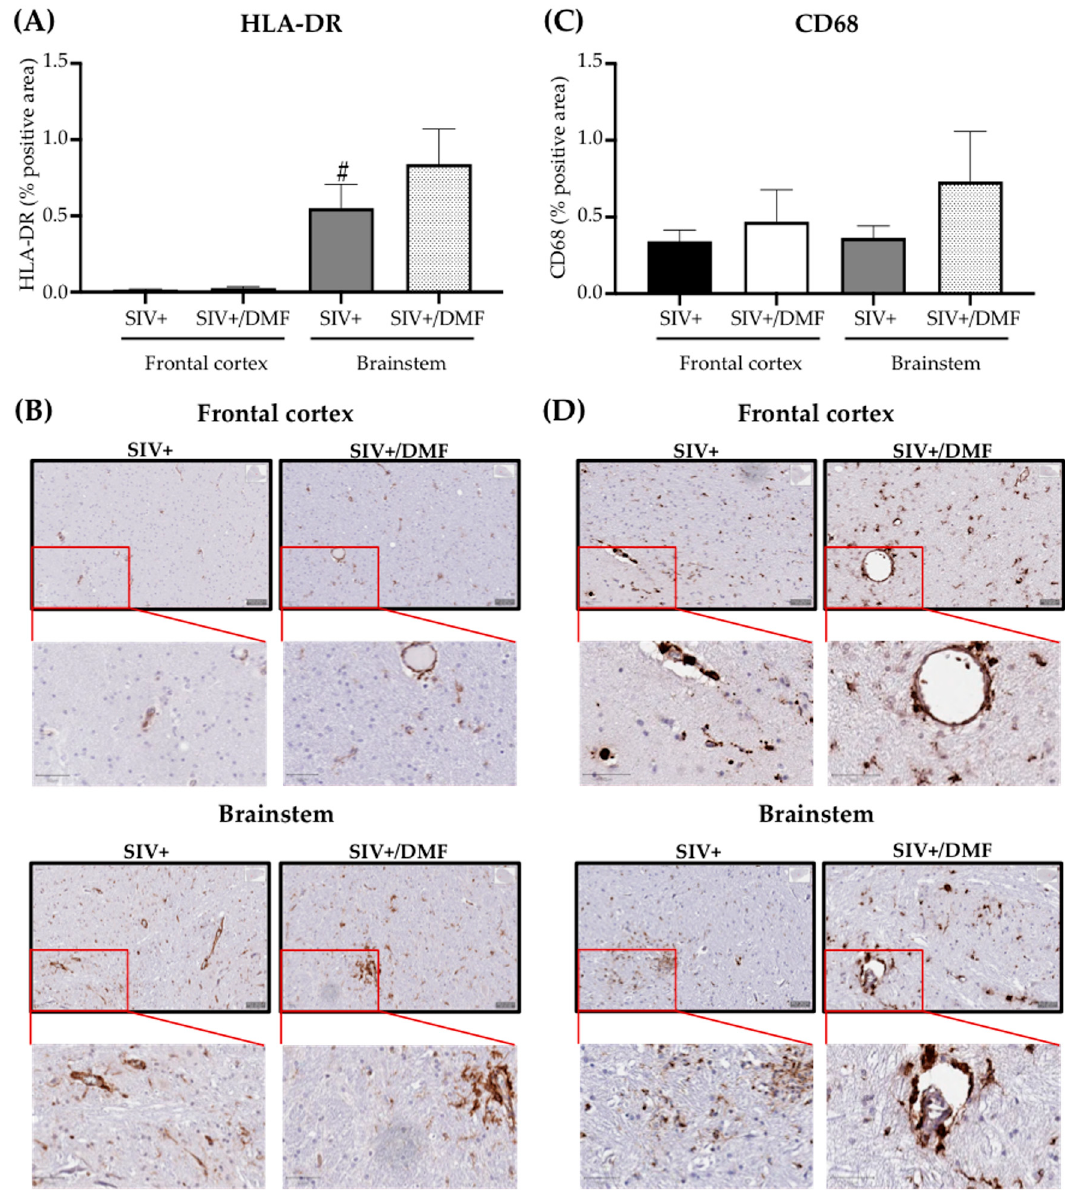
Figure 13. DMF treatment was not associated with the altered brain expression of HLA-DR (monocyte/microglia activation) or CD68 (monocyte marker). ( A ) Quantification of HLA-DR in the frontal cortex and brainstem. The brainstem showed a higher expression of HLA-DR than the frontal cortex (statistical analysis was done with Student’s unpaired t -test, # p < 0.05 comparing the frontal cortex vs. the brainstem in the SIV+ group) and the DMF treatment showed no effect on the HLA-DR expression. ( B ) Representative labeling for HLA-DR in the frontal cortex (top panels) and brainstem (bottom panels). ( C ) Quantification of CD68 in the frontal cortex and brainstem. The DMF treatment showed no effect on the CD68 expression. ( D ) Representative labeling for CD68 in the frontal cortex (top panels) and brainstem (bottom panels). Four contiguous sections from each region were harvested from each animal for labeling with each antibody. Nine SIV-infected rhesus macaques were used in the study (4 untreated animals and 5 DMF-treated (90 mg total DMF daily)). Images from all sections were taken using a digital slide scanner (Aperio AT2, Leica Biosystem, Wetzlar, Germany) at 20x magnification and were analyzed with QuPath software (version 0.2.0-m5), as previously reported [46]. Quantifications are expressed as the mean percent of positive staining from all the stained areas ± SEM.